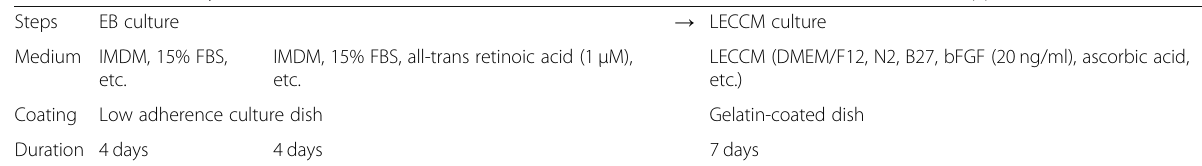
Table 2 The summary of Chen ’ s methods (2015). IMDM; Iscove ’ s modified Dulbecco ’ s medium. N2; N2 supplement Steps EB culture → LECCM culture Medium IMDM, 15% FBS,